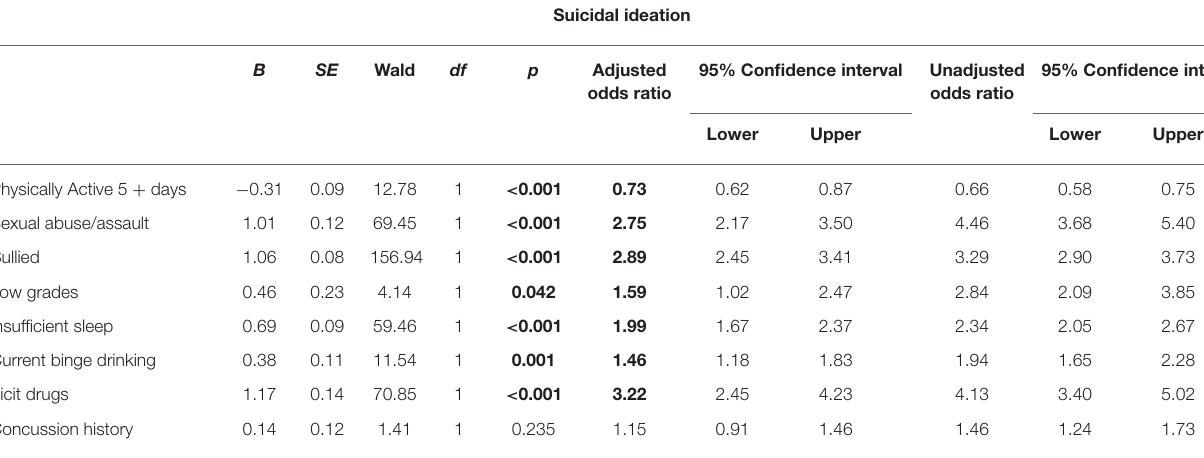
TABLE 5 | Logistic regressions predicting suicidality in girls (reduced set of